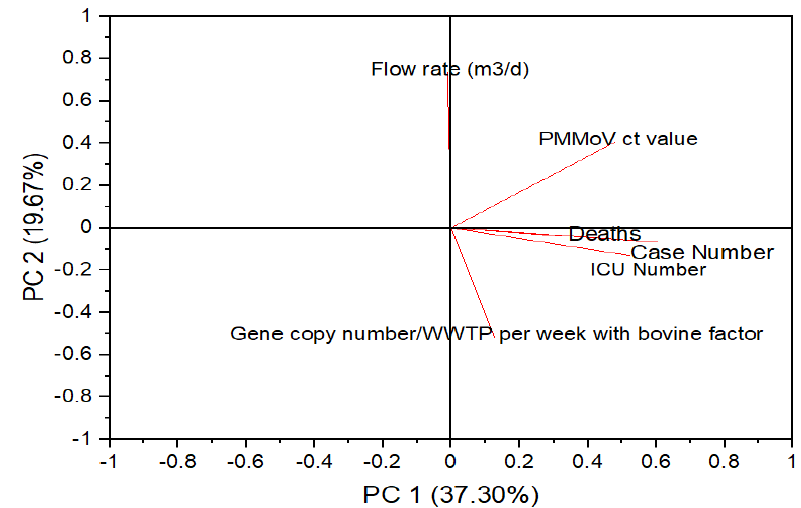
Figure 4. PCA loading plot, illustrating the relation and interaction among the wastewater parameters and the SARS-CoV-2-positive cases, ICU number, and deaths in Stockholm.